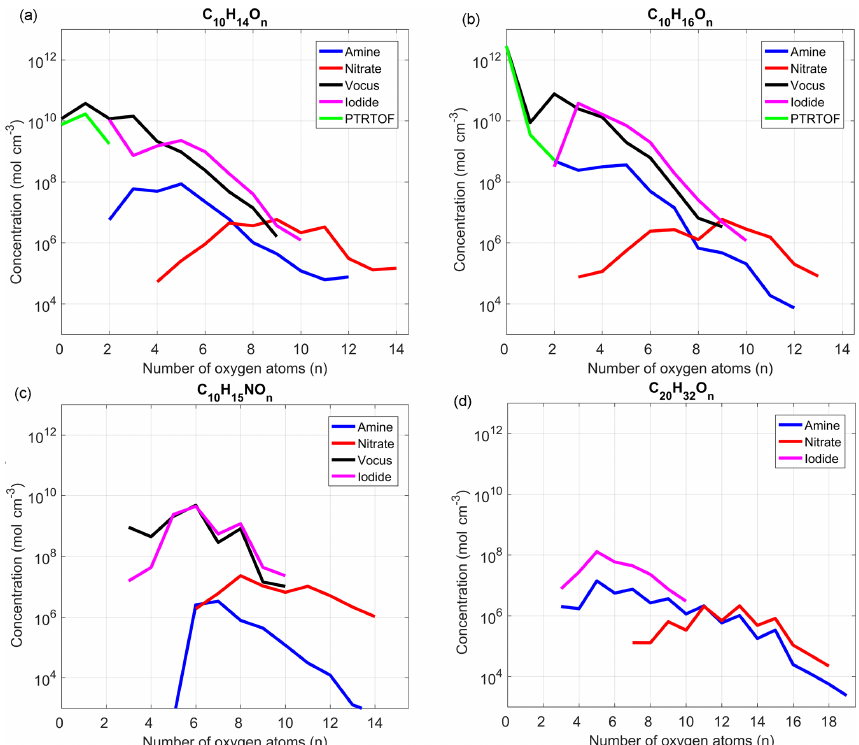
Figure 5. Estimated concentrations of the main α -Pinene C 10 -monomer oxidation products (a, b) , C 10 -monomer organonitrates (c) and α -Pinene dimers (d) by the different mass spectrometers deployed in this study. The average concentrations were estimated when the system reached steady state in two experiments: without NO (a, b, d) , 9 December (15:30–23:00), and with NO (c) , 20 December (02:45 to 07:45). See text for more details. Data are plotted only for ions for which the average concentrations were higher than 3 times the standard deviation during the